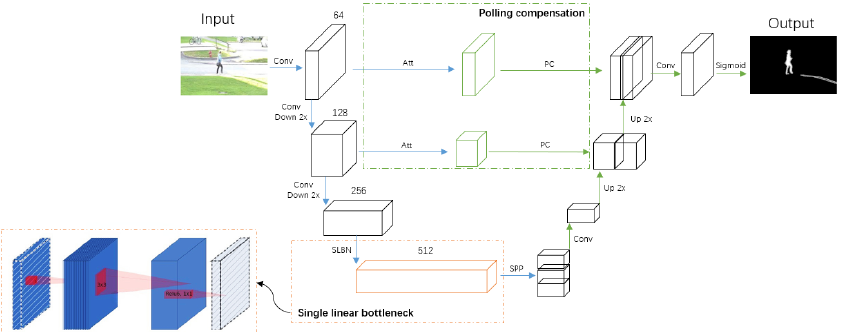
Figure 1. Overview of our MDNet-LBPC. The single-linear bottleneck operator is used to reduce the computational complexity of the model. The polling compensation mechanism is used to reduce information loss caused by channel compression. “Conv” indicates convolution operation, “Down” indicates maxpooling and upsampling operation. “SPP” indicates spatial pyramid pooling layer.